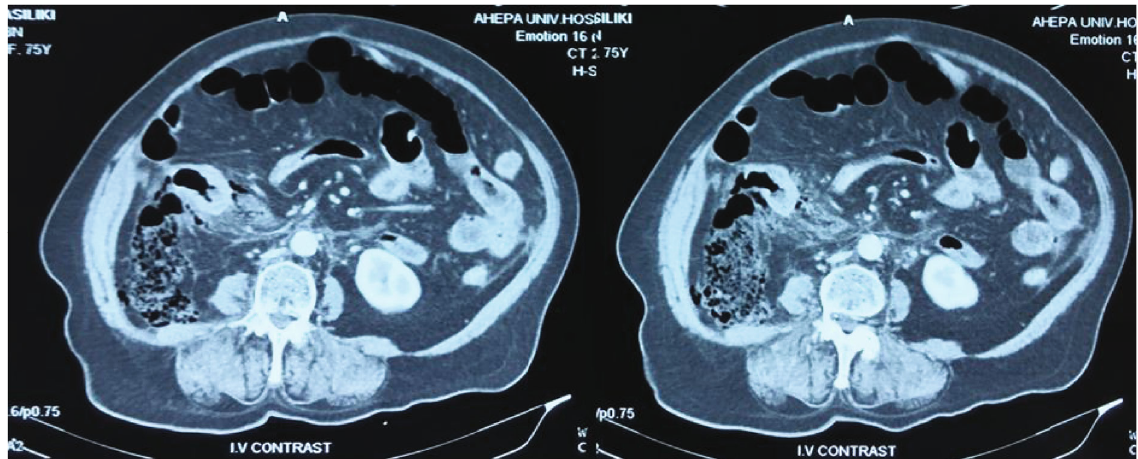
Figure 1: CT scan images showing retrocecal collection of fecal matter, without any presence of free air or fl uid collection in the peritoneal